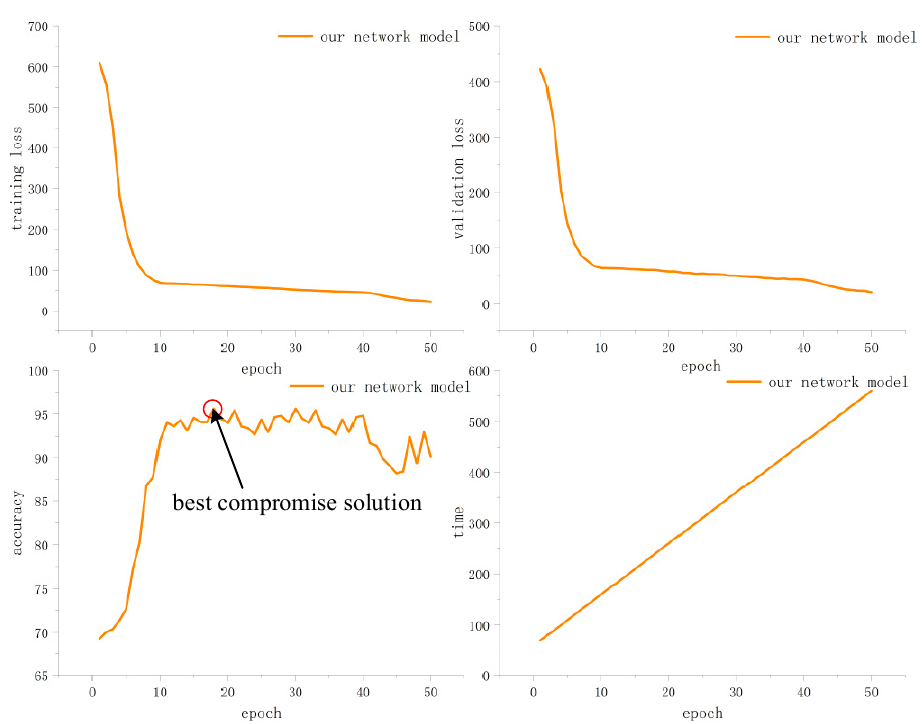
Figure 4. Visualize the effect of hyperparameters (epochs) on training results.